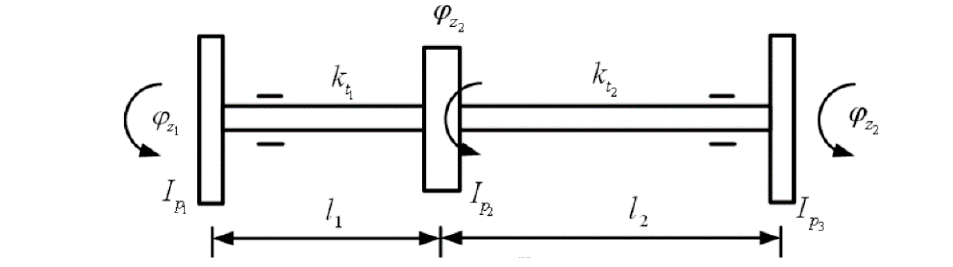
Figure 3. A three (3) DOF torsional system.